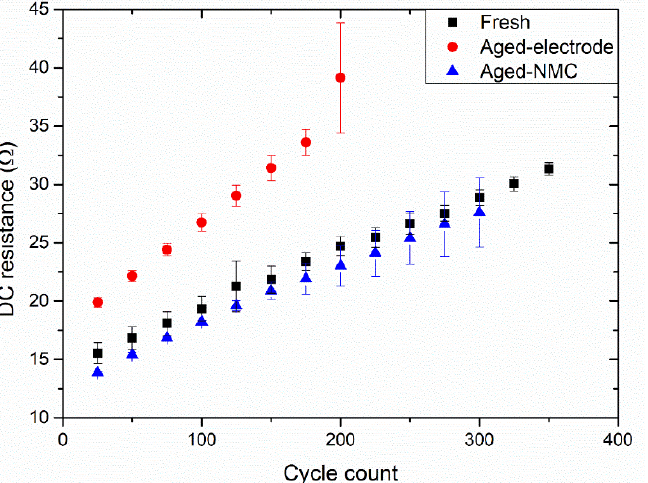
Figure 3. DC resistance evolution during the cycle life of the cells with different cathodes: fresh (black squares), aged-NMC (blue triangles) and aged-electrode (red circles). Error bars indicate the standard deviation between the different cells with the same cathodes.